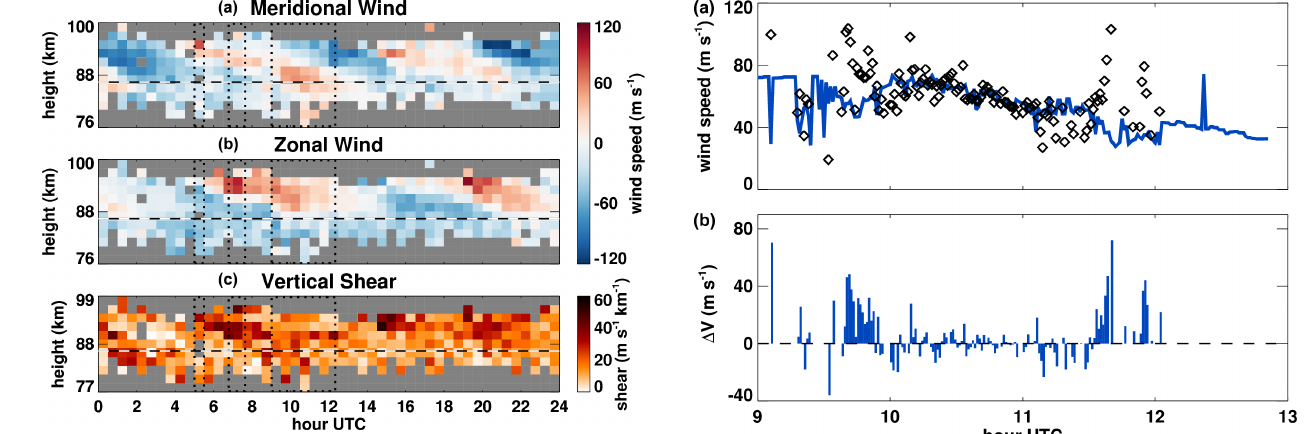
Figure 7. (a) Horizontal wind estimates made using 1min PMSE range–Doppler fitting (diamonds) and a moving 30min window of meteor trail detections (solid line). (b) Deviation between meteor and PMSE range–Doppler wind